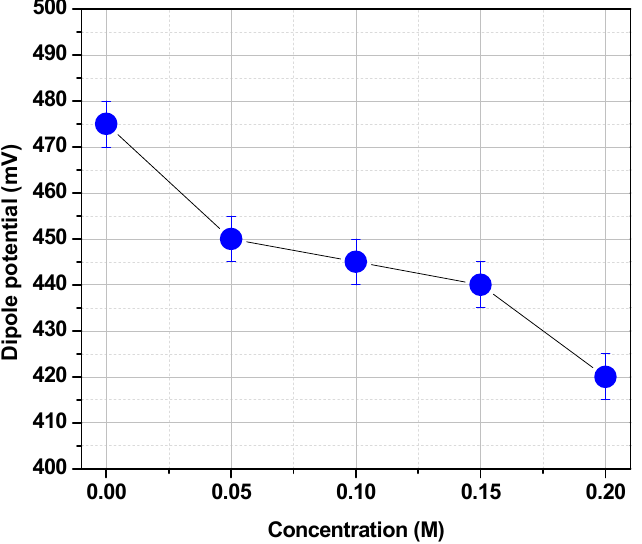
The dipole potential can also be modified by the orientation of the constitutive lipids. The dipole moment is the resultant of the total dipole moment and the angle with respect Figure 7. Effect of Trehalose ( • ) on the dipole potential of DMPC monolayers spread in an to the membrane plane (Figure 8). Figure 7. Effect of Trehalose ( ● ) on the dipole potential of DMPC monolayers spread in an air/aque- air/aqueous solution interface at 20 ◦ C. (Adapted from ref. [37]). ous solution interface at 20 °C. (Adapted from ref. [37]).